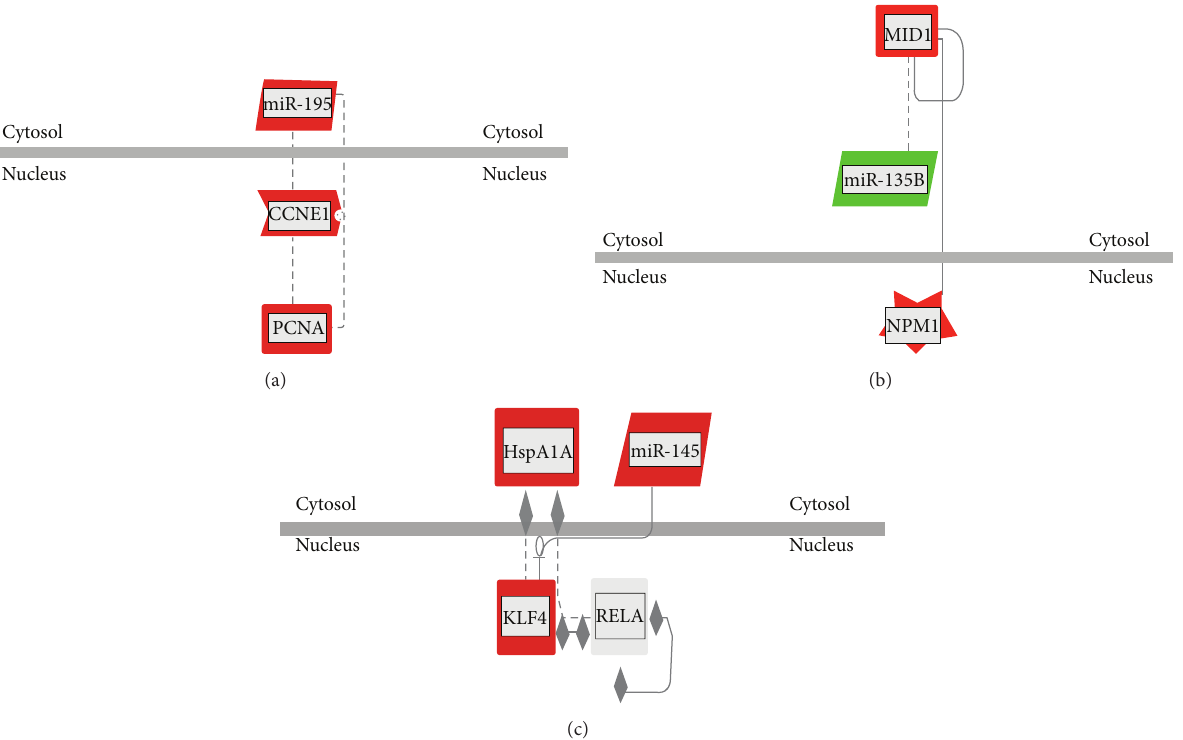
Figure 6: Subnetworks of microRNAs, proteins, and genes putatively involved in the maintenance of hMB-SLCs proliferation. (a) miR-195 has direct connections to CCNE1 that targets PCNA. (b) NPM1 (NPM) interacts with MID1 that targets the oncogenic microRNA, miR-135b. (c) miR-145 regulates the stemness marker KLF4 that interacts both with p65 and with the heat-shock protein